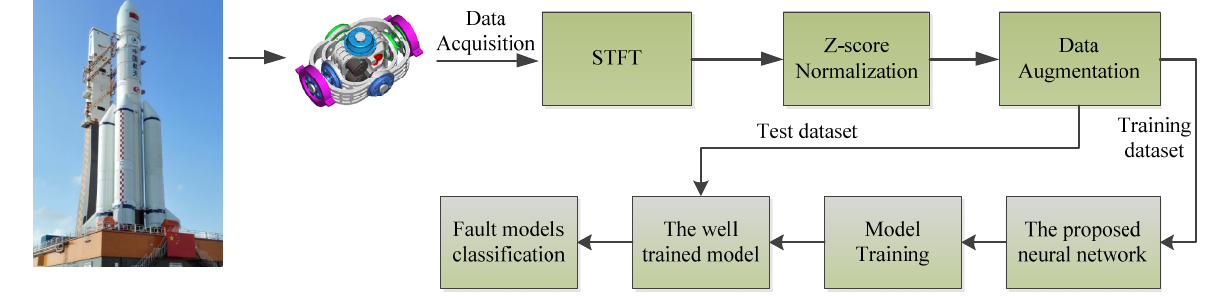
Figure 4. The framework of the proposed fault diagnosis